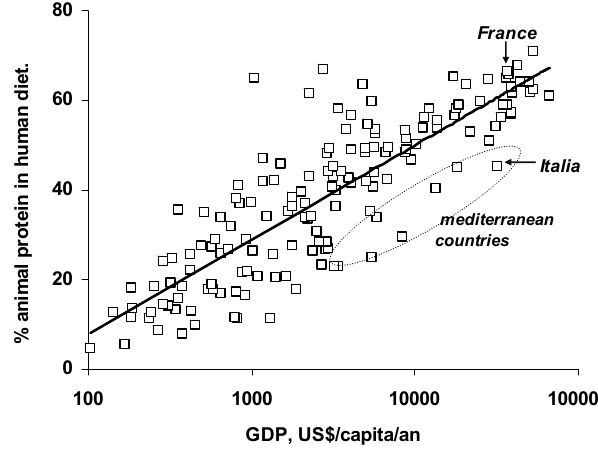
Fig. 4. Share of animal products in human total protein consump- tion of the world’s countries in 2003, plotted against their GDP (sources: FAOstat,